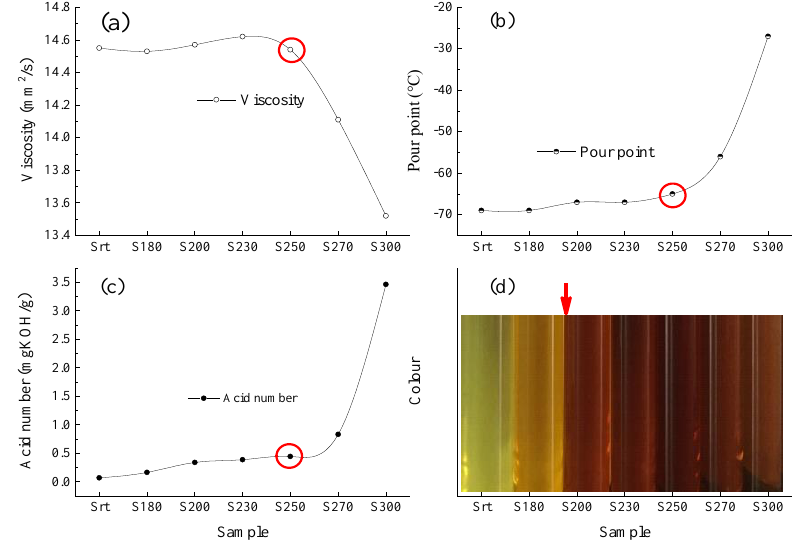
Figure 7. Kinematic viscosity at 40 °C, pour point, acid number, and color of the oil samples as a function of temperature. ( a ) Kinematic viscosity; ( b ) Pour point; ( c ) Acid number; ( d ) Colour.